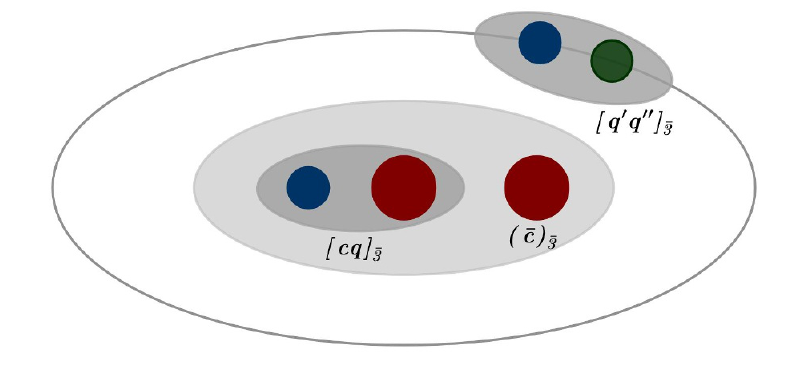
Figure 1 . A picture of pentaquarks in the diquark model involving the heavy diquark [ cq ] (cid:22)3 and charm antiquark ((cid:22) c ) (cid:22)3 , which form the triquark system, which combines with the light diquark [ q 0 q 00 ] (cid:22)3 to make a color singlet pentaquark. The subscripts indicate that all three constituents are color anti-triplets; q , q 0 , and q 00 are light quarks each of which can be u -, d -, or s -quark. d -quarks, assuming the isospin symmetry, are given in table 8. Masses of the